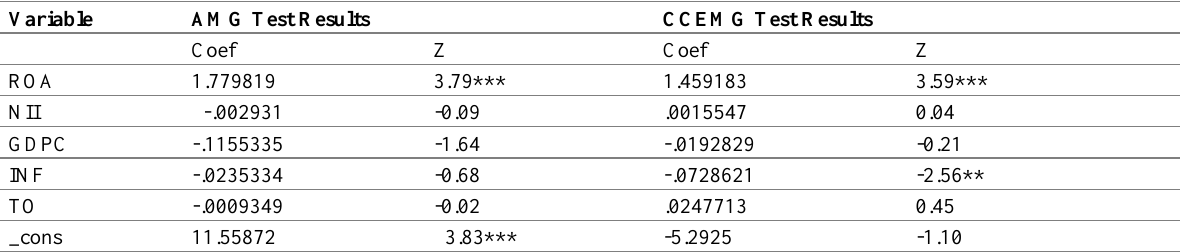
Table 6: Test for Long Term